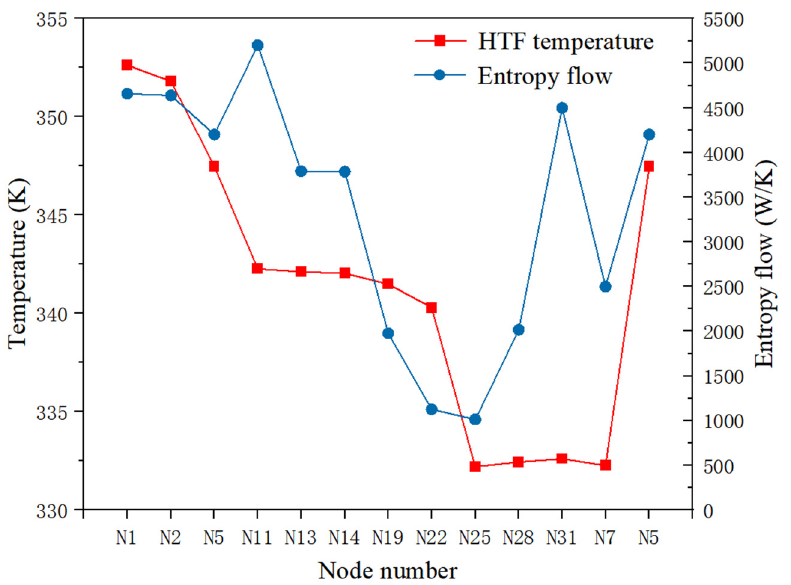
Figure 3. Water supply temperature and entropy flow of typical nodes in Case I.